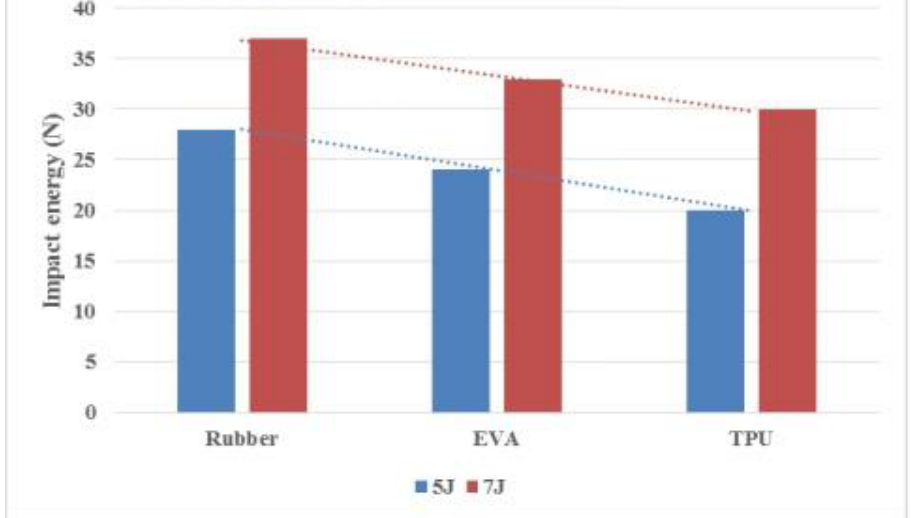
Figure 2: Comparison of G value under different impact energy